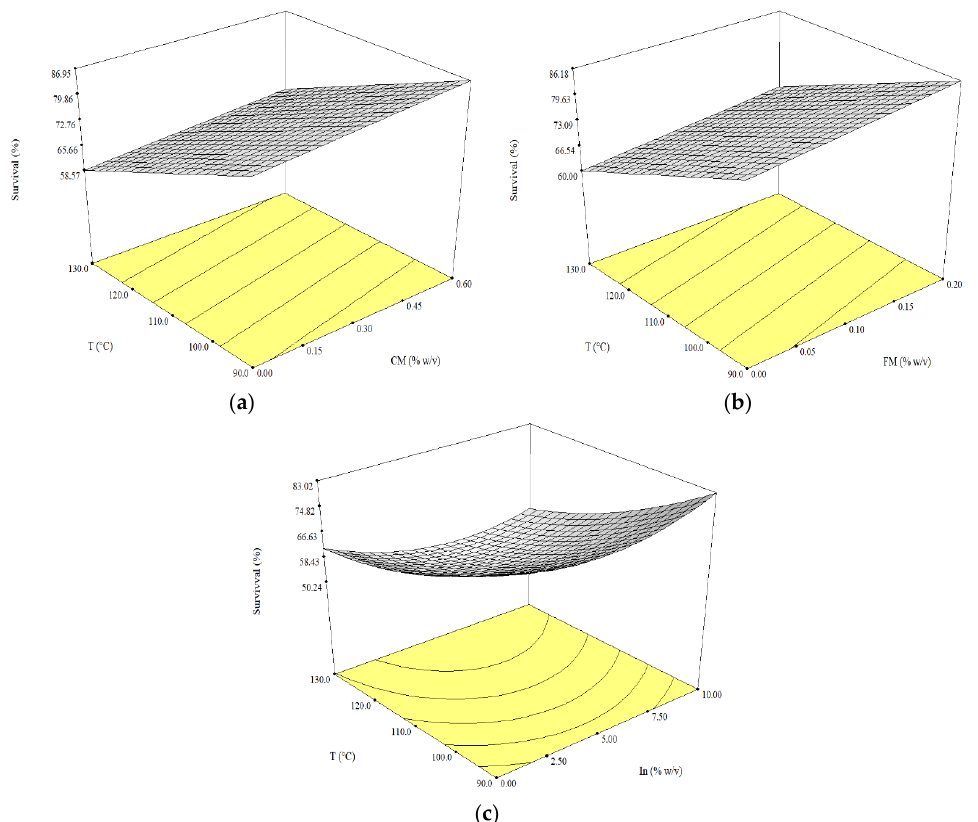
Figure 1. Three-dimensional surface plot for the survival of L. rhamnosus after spray drying. ( a ) Chia seed mucilage (CM) and drying inlet air temperature (T), ( b ) Flaxseed mucilage (FM) and drying inlet air temperature (T), ( c ) Inulin (INL) and drying inlet air